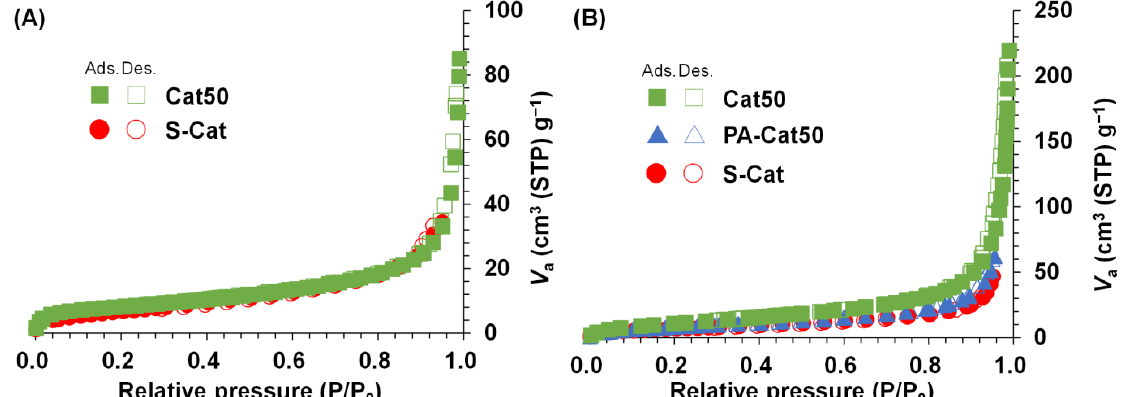
Figure 4. N 2 adsorption/desorption isotherms of ( A ) support and ( B ) catalyst samples.